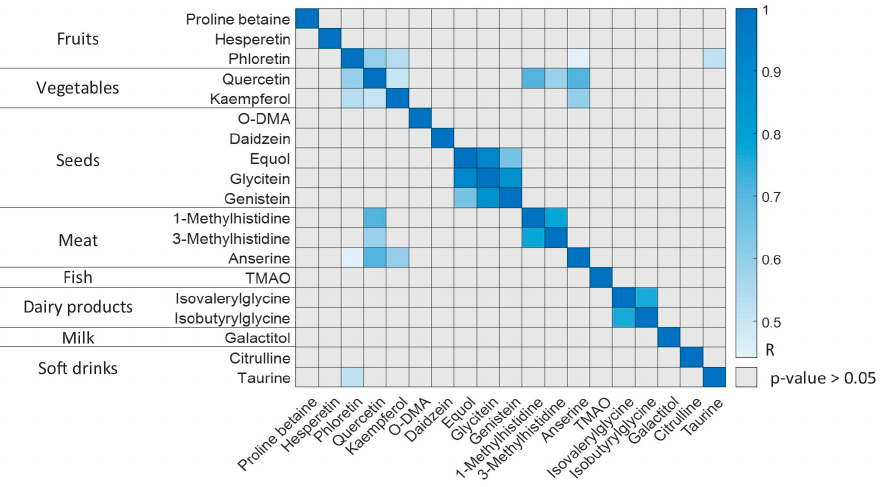
Figure 2. Signi fi cant paired correlations among BFIs (Pearson’s correlation, p -value < 0.05). Figure 2. Significant paired correlations among BFIs (Pearson’s correlation, p -value < 0.05).